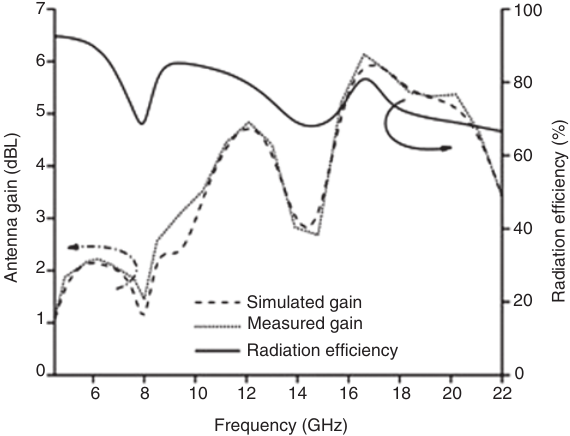
Figure 15: Radiation efficiency and realized gain of the proposed